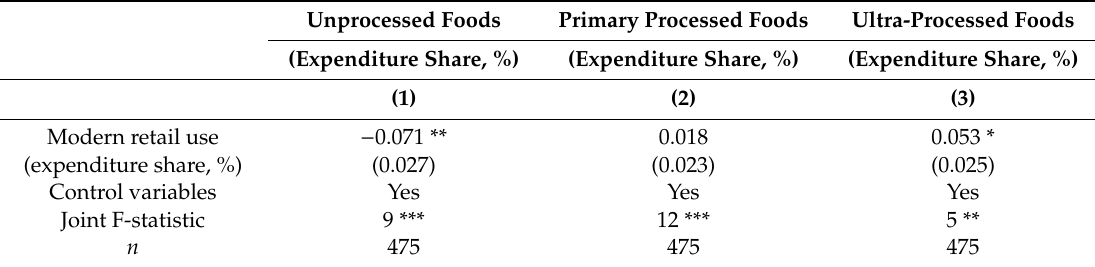
Table 3. E ff ects of using modern retailers on dietary composition in terms of food processing